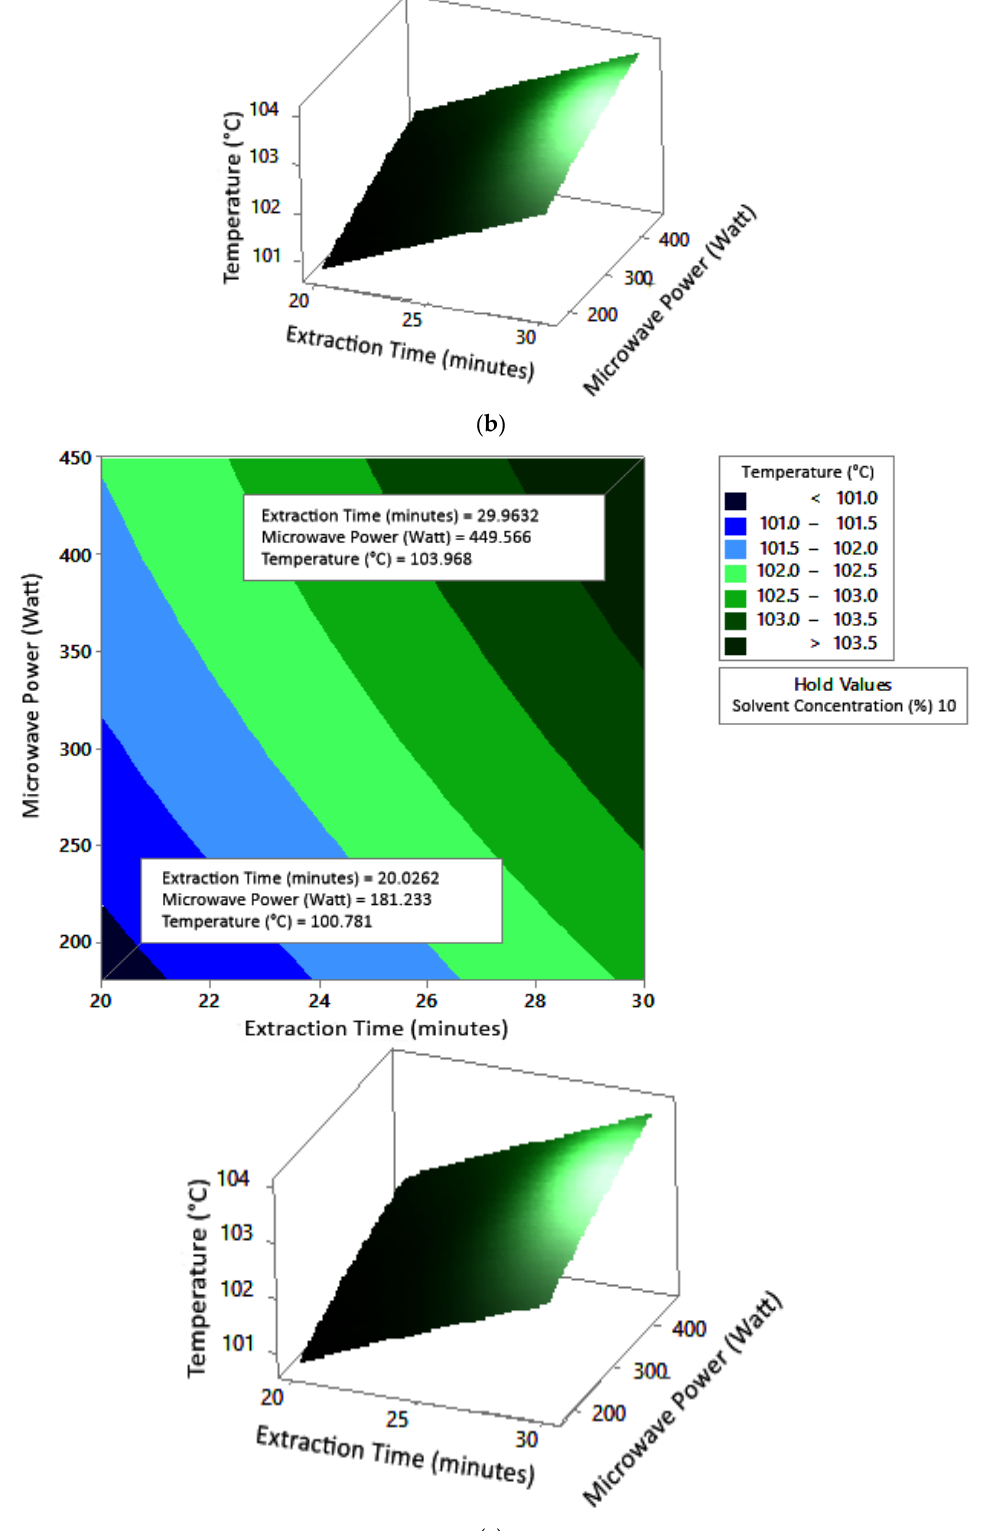
Figure 5. Effect of extraction time and microwave power on temperature at solvent